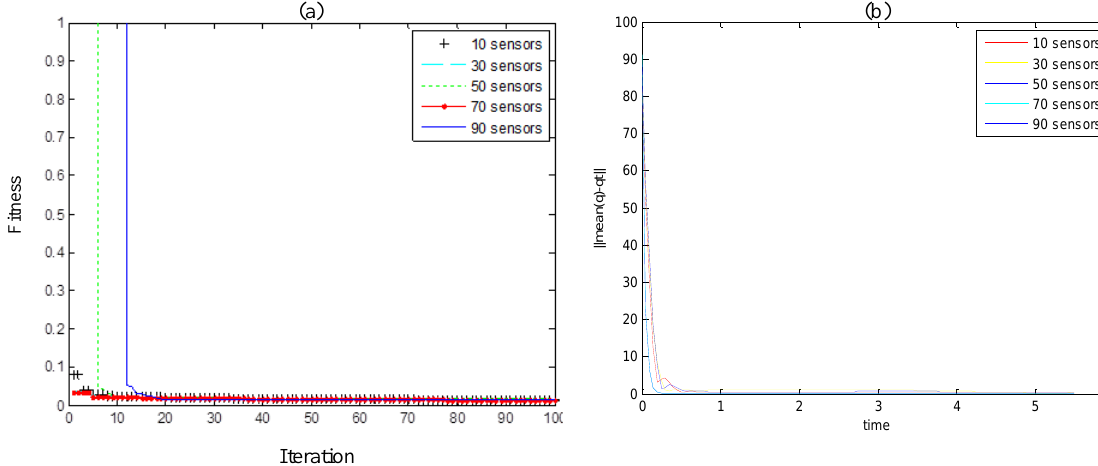
Figure 9. (a) Value of cost function for various numbers of sensors during 100 iterations, (b) errors between COM of locations of robots and location of target in circular trajectory for different numbers of